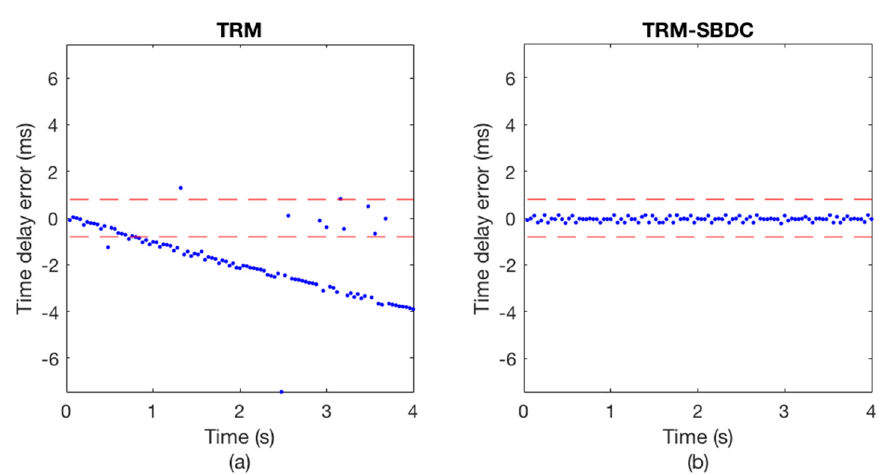
Figure 8. The Doppler time delay error. ( a ) TRM; ( b ) TRM-SBDC.